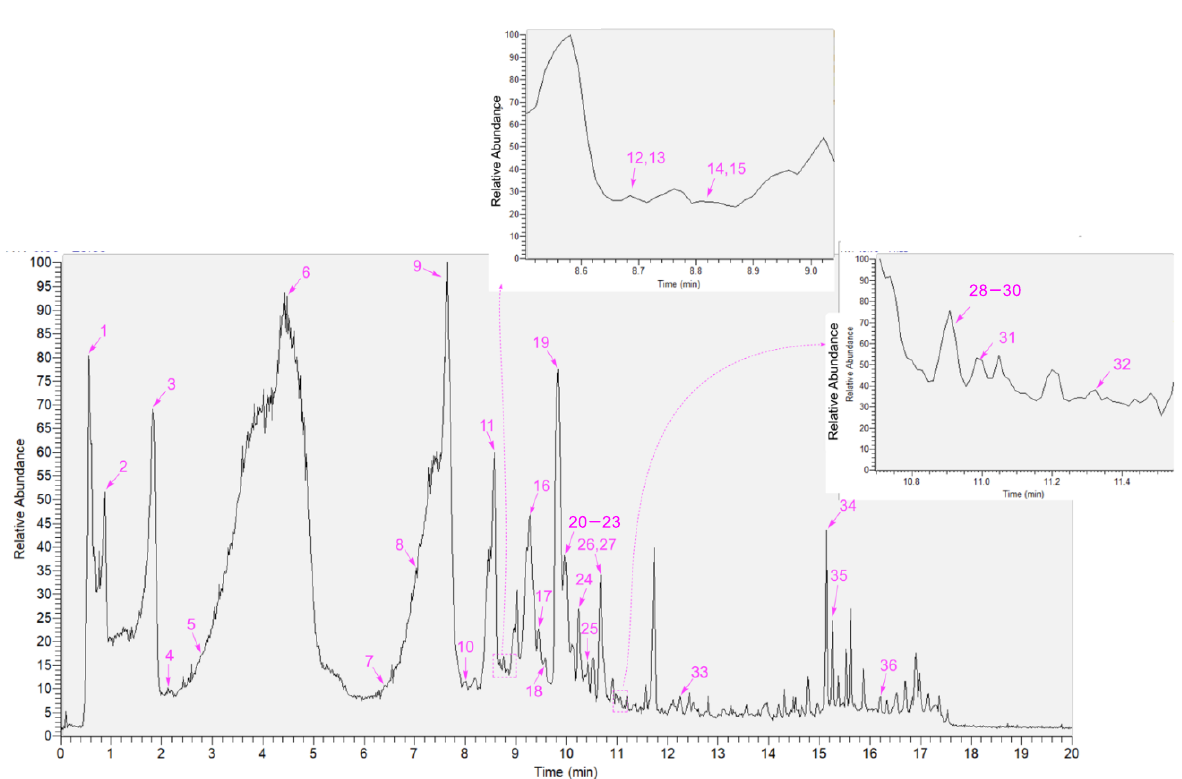
Table 1. The putative identification was achieved via multiple comparisons with the cor- responding authentic standards. The parameters included R.T. value, molecular ion peak, MS/MS profile and characteristic fragments. Through these comparisons, 36 bioactive compounds were putatively identified. They are listed in Figure 3. One compound, am- pelopsin, was identified from evidence set out in Figures 4 and 5.